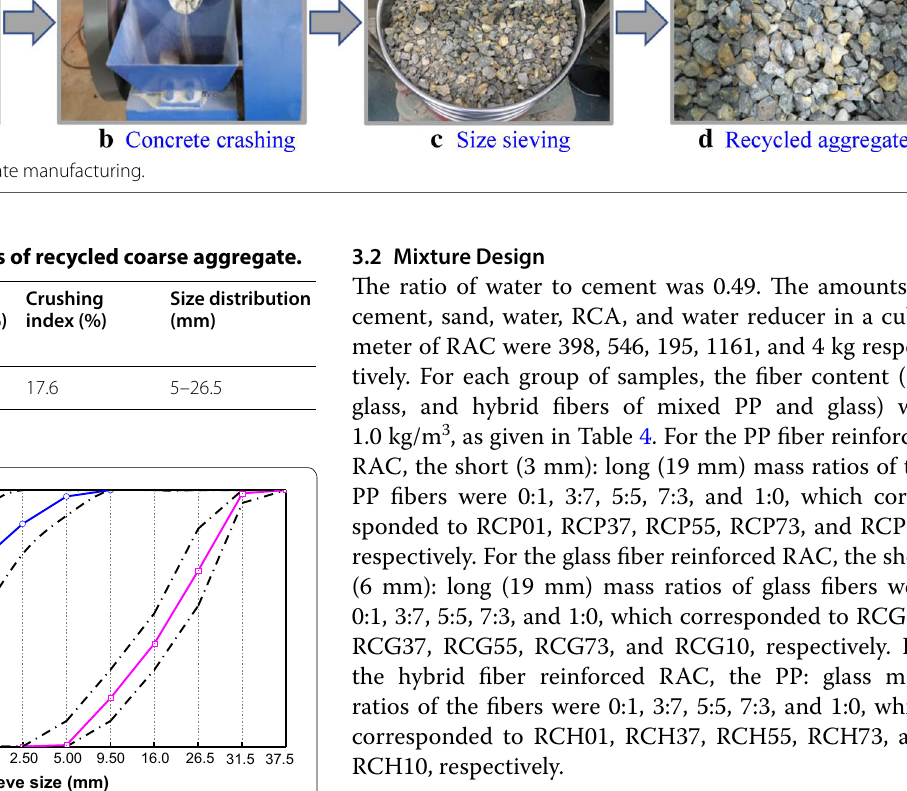
Fig. 2 Fine and coarse aggregate grading